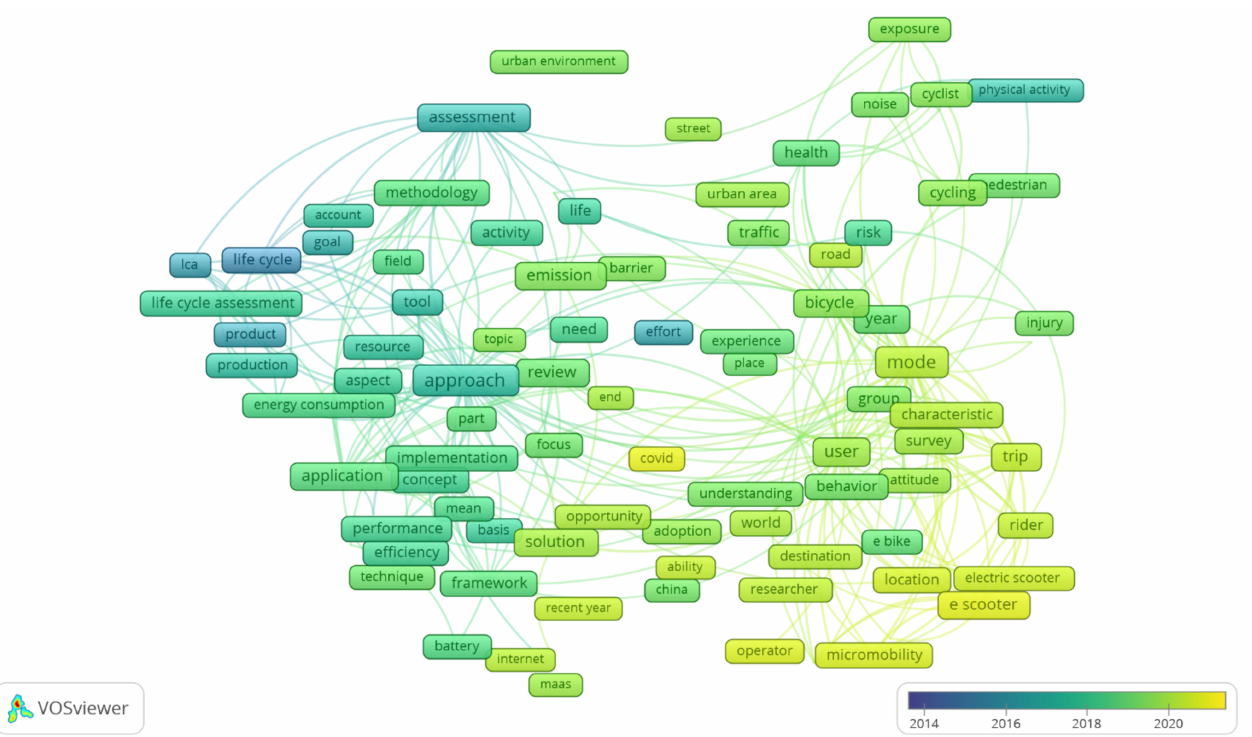
Figure 4. Overall visualization analysis of topics addressed in the titles and abstracts of all 360